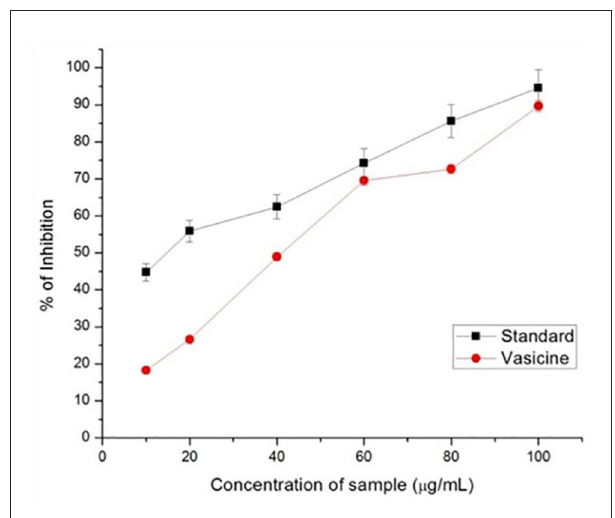
FIGURE7 HIV-protease inhibitory activity of vasicine and the standard